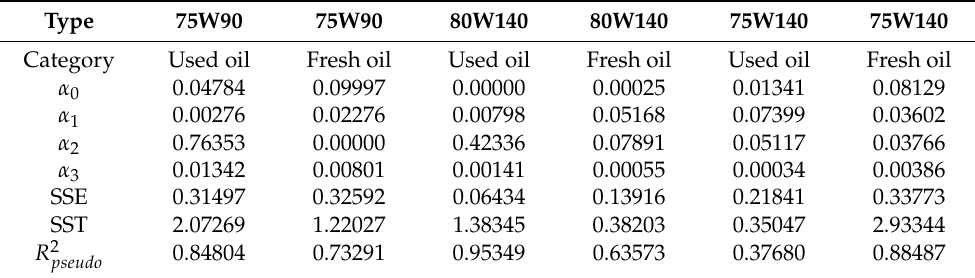
Table 2. Parameter values of Function (1) for different types of oils and values for fitting this function to real